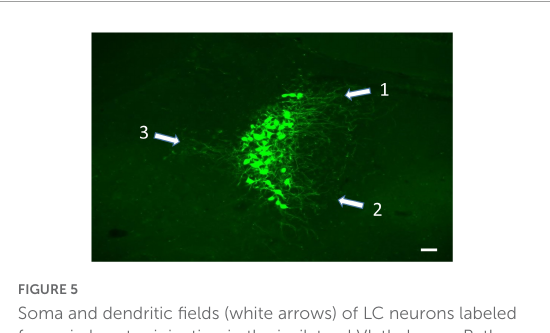
FIGURE5 Soma and dendritic fields (white arrows) of LC neurons labeled from viral vector injection in the ipsilateral VL thalamus. Rather than extend evenly into the peri-coerulear surround, the dendrites from these cells are concentrated in the dorsomedial (1) , ventromedial (2) , and lateral (3) zones of the peri-coerulear space, scale bar = 100 µ